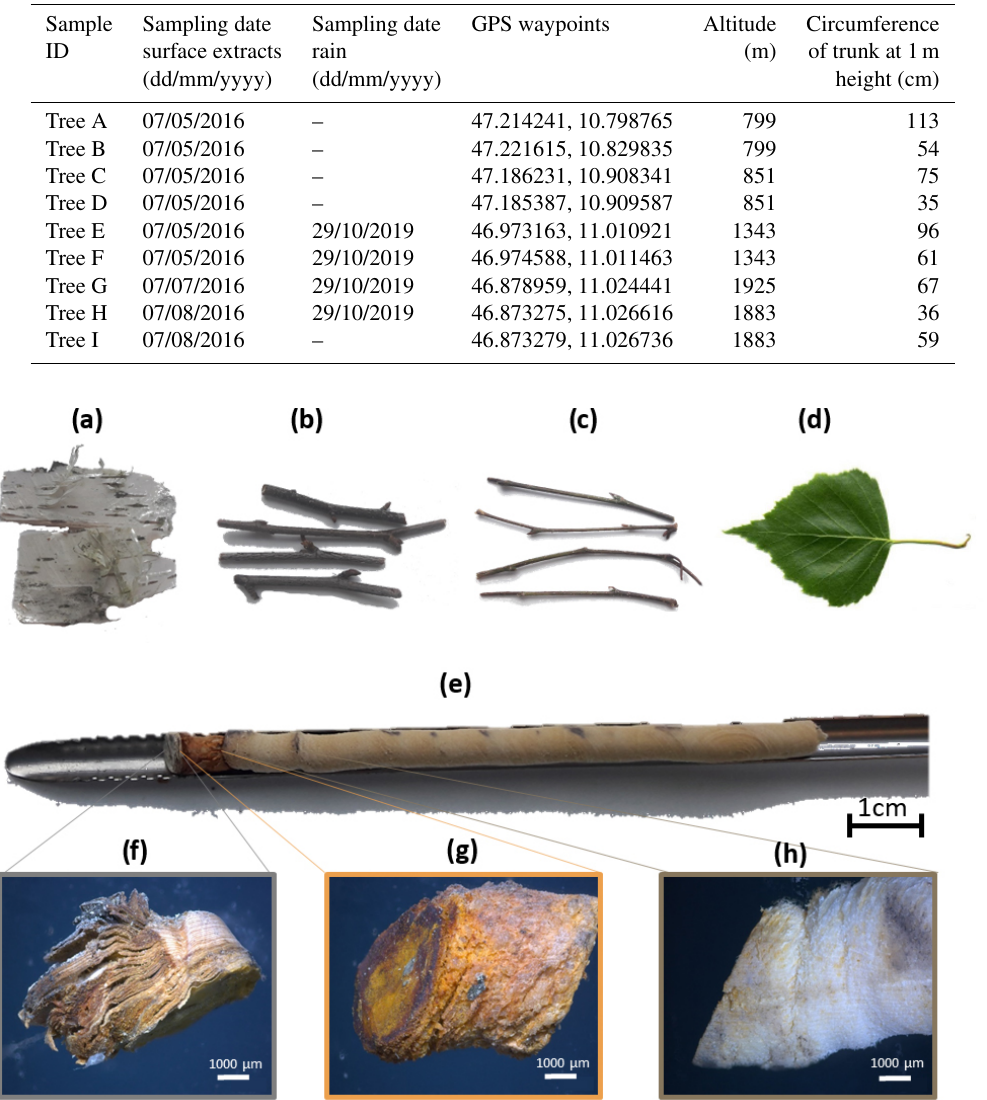
Figure 2. Type of samples collected. (a) Bark, (b) secondary wood, (c) primary wood, (d) leaves and (e) drill core. Microscopic pictures of (f) bark, (g) bast and (h) inner wood from the drill core (Tree